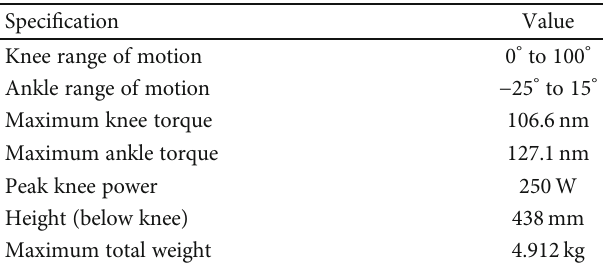
Figure 3: FE analysis to obtain the proper thickness of the plate spring at the ankle joint. Table 1: Design objectives considering body